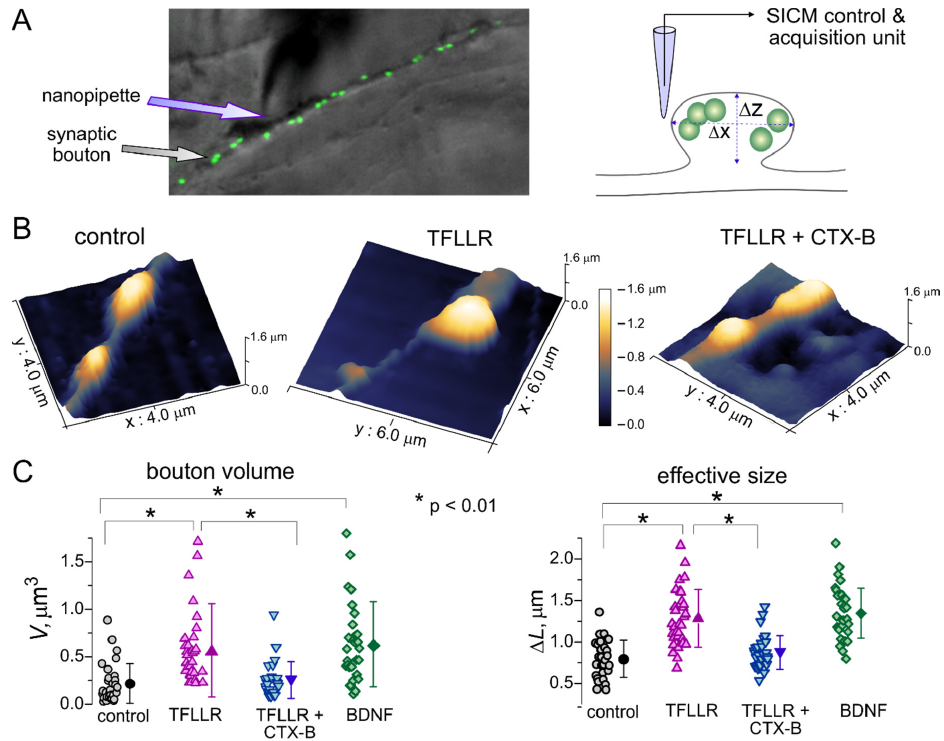
Figure 2. Astroglia and BDNF regulate synaptic size. ( A ) The principle of tomographic imaging of synaptic boutons using the high-resolution hopping probe scanning ion conductance microscopy (SICM). Synapses of live hippocampal neurons were stained with synaptic vesicle marker FM1-43. ( B ) High-resolution SICM 3D images of hippocampal synapses of wild-type neurons in control and after 24 hour-incubation with 3 µM TFLLR or TFLLR and Cyclotraxin B (10 nM). The X-, Y- and Z-scales are indicated at the images, the Z-scale is highlighted as pseudo-color (same Z-scale for all three images). ( C ) The pooled data on the size and volume of synaptic boutons of wild-type neurons in control and after 24 hour-incubation with TFLLR, TFLLR and Cyclotraxin B (10 nM), and BDNF (100 ng/mL). Open symbols indicate individual boutons, the closed symbols show mean ± SD ( n = 30–35 boutons from three preparations). Note the significant increase in the size and volume of synapses after incubation with TFLLR or BDNF.